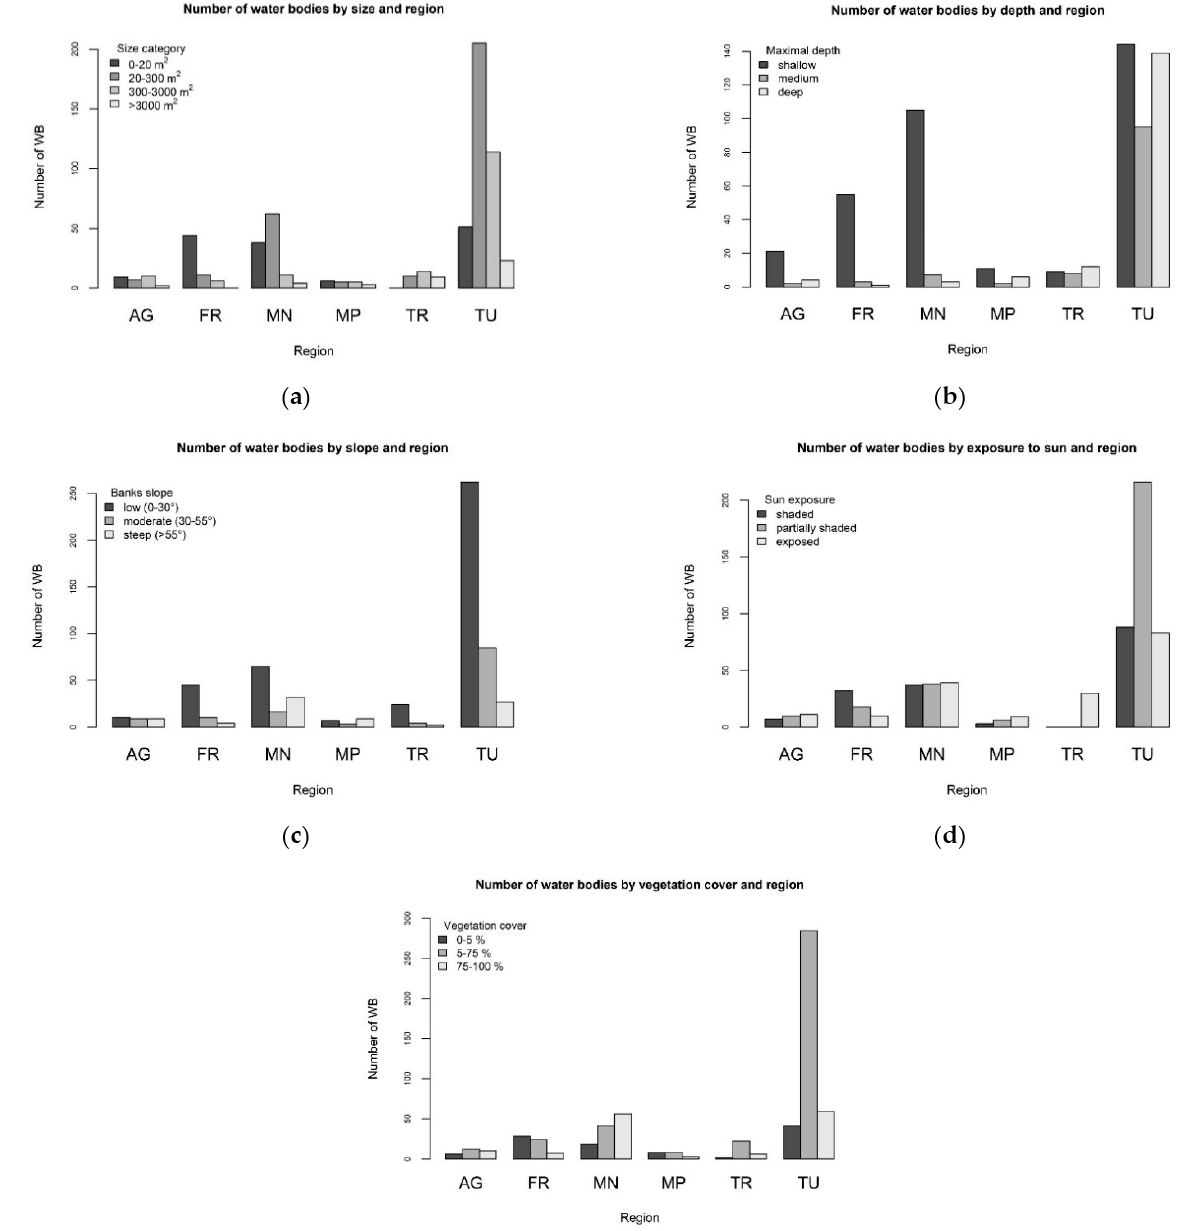
Figure 3. Comparison of environmental characteristics of water habitats among landscape types: number of water bodies by ( a ) size; ( b ) dept; ( c ) slope; ( d ) insolation of water surface; ( e ) vegetation cover. AG = agricultural landscape; FR = forest landscape; MN = mountain landscape; MP = meadows and pastures; TR = technically reclaimed spoil banks; TU = technically unreclaimed spoil banks.